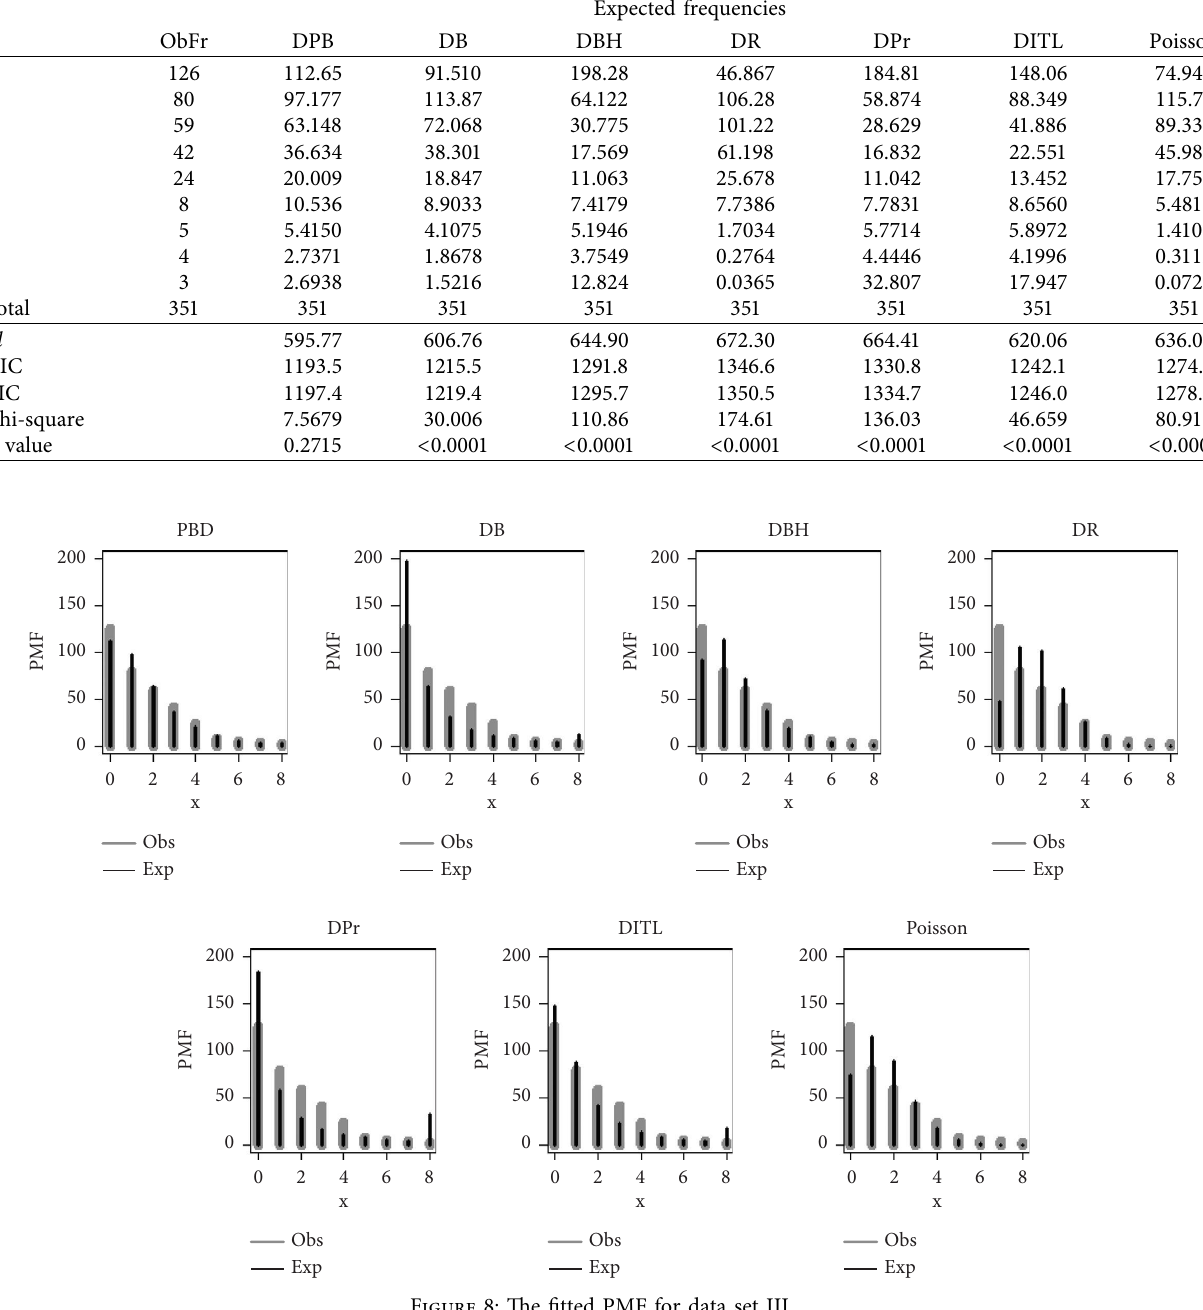
Table 14: Te GOF measures for data set III.